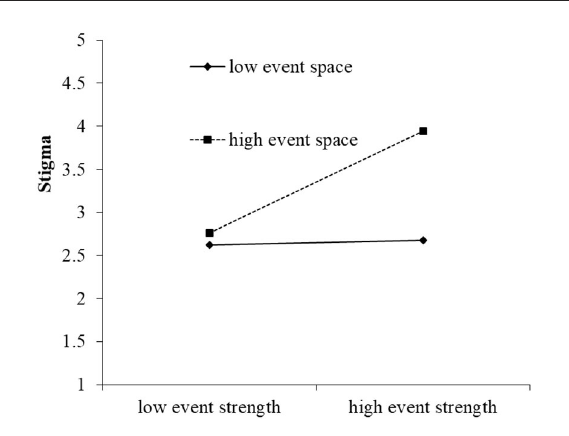
FIGURE4 The moderating effect diagram of event space between event strength and stigma.